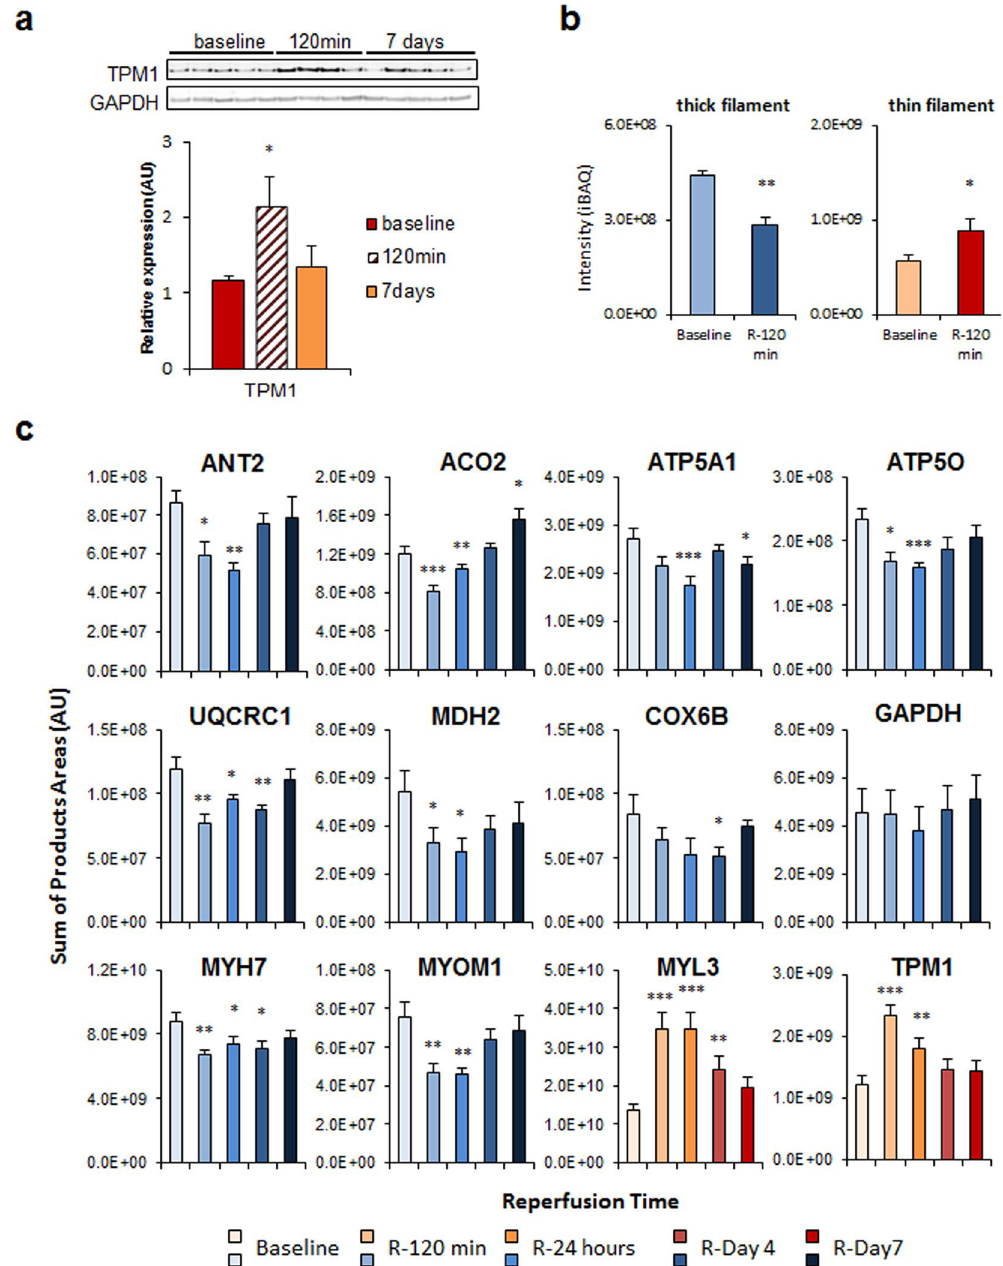
Figure 6. Validation of the most representatitve protein changes detected in remote myocardium after acute infarction. ( a ) Western blot analysis and quantitative densitometry of TPM1 confirming the transient increase in thin filament sarcomeric proteins early after reperfusion. Full-length blots are presented in Supplementary Figure S8 as well as their raw integrated densities before and after normalization can be consulted in Supplementary Figure S12. Protein values are normalized relative to GAPDH. Results are shown as the mean ± s.e.m. of values obtained in at least four animals. * Indicates p value < 0.05 versus baseline by Mann-Whitney test. ( b ) Label free proteomics analysis confirming the decrease in thick filament proteins and an increase in thin filament proteins early after reperfusion (in at least four animals). Results are expressed as in Fig. 4d. Label free individual protein quantifications included in the thick filament and thin filament protein groups are shown in Supplementary Figure S14. ( c ) Quantitative analysis by PRM targeted proteomics of proteins ANT2, ACO2, ATP5A1, ATP5O, UQCRC1, MDH2, COX6B, GAPDH, MYH7, MYOM1, MYL3 and TPM1, confirming the transient changes in abundance of mitochondrial and contractile sarcomeric proteins after early reperfusion. Protein values are normalized by the total base peak area of the chromatograms. Results are shown as the mean ± s.e.m. of at least four animals at each time point in two technical replicates. * Indicates p value < 0.05; ** indicates p value < 0.01, *** indicates p value < 0.001 versus baseline by Mann-Whitney test. iTRAQ quantifications of the proteins from panels a and c are shown in the Supplementary Figure S11b for